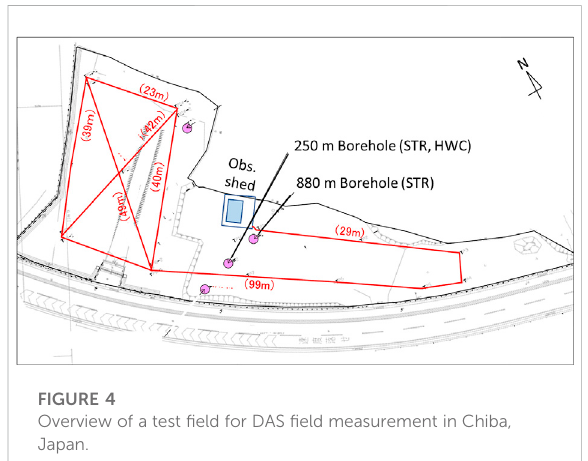
FIGURE 5 Positions of shot points and the observation site for a walk- away VSP conducted in January